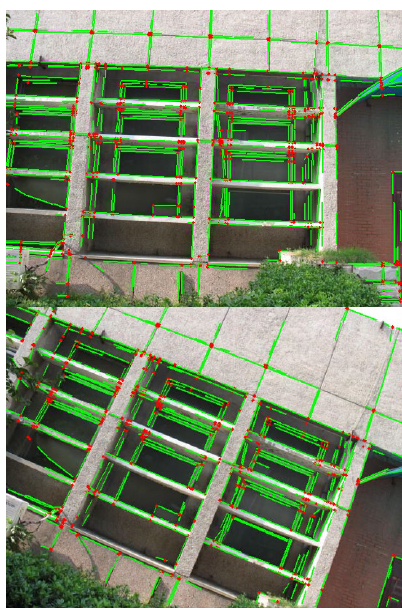
Figure 2. Line-pairs generated for both images. The intersection points of line-pairs are depicted as red dots